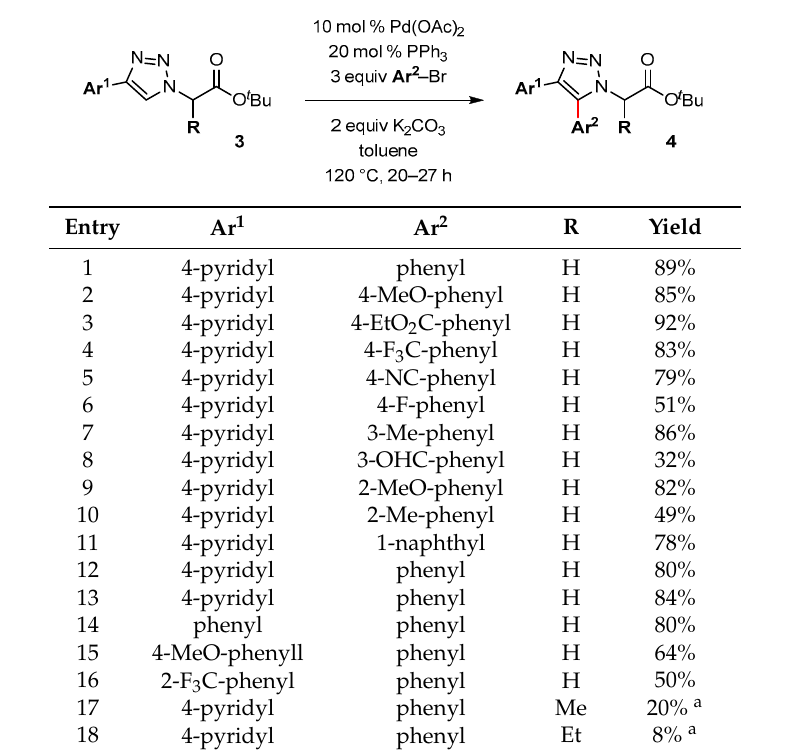
Table 2. Scope of palladium-catalyzed C–H arylation of triazoles.